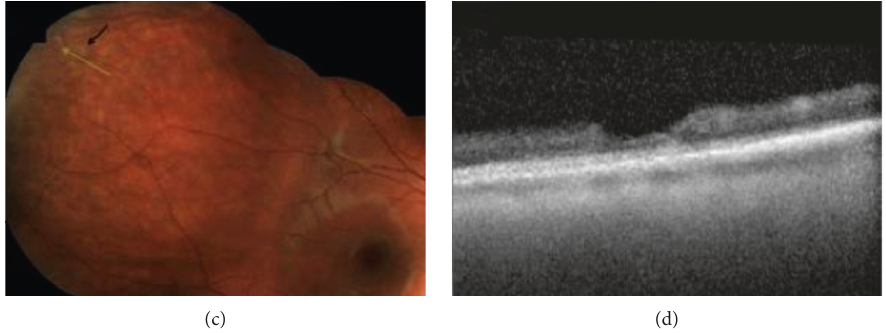
Figure 2: Peripheral SD-OCT of operculated breaks and focal operculated schisis. (a) Peripheral photograph of the left eye of this asymptomatic patient with an operculated break; black arrow denotes operculum; green line scan demonstrates scan position through the break. (b) SD-OCTreveals a full-thickness retinal break. (c) Photograph of the right eye of this symptomatic patient with an apparent full- thickness operculated break. (d) SD-OCT reveals focal operculated schisis with no full-thickness component.